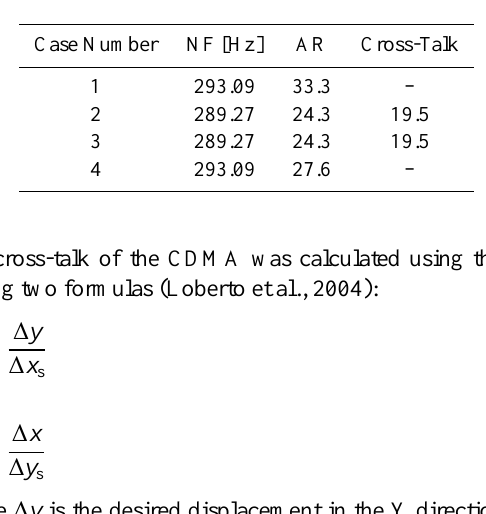
Fig. 4. Contour plot of the Von-Mises stress of the initial CMDA. Figure 4. Contour plot of the Von-Mises stress of the initial 5.